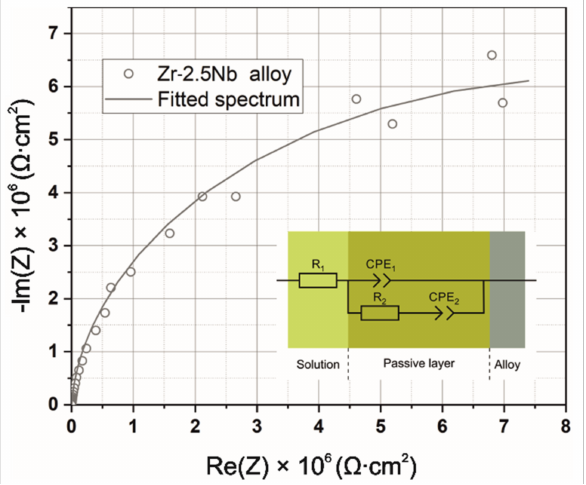
Figure 16. Nyquist impedance plot and equivalent circuit for the Zr-2.5Nb alloy. Table 3. Equivalent circuit parameters calculated by means of fitting for the Zr-2.5Nb alloy. Element of Equivalent